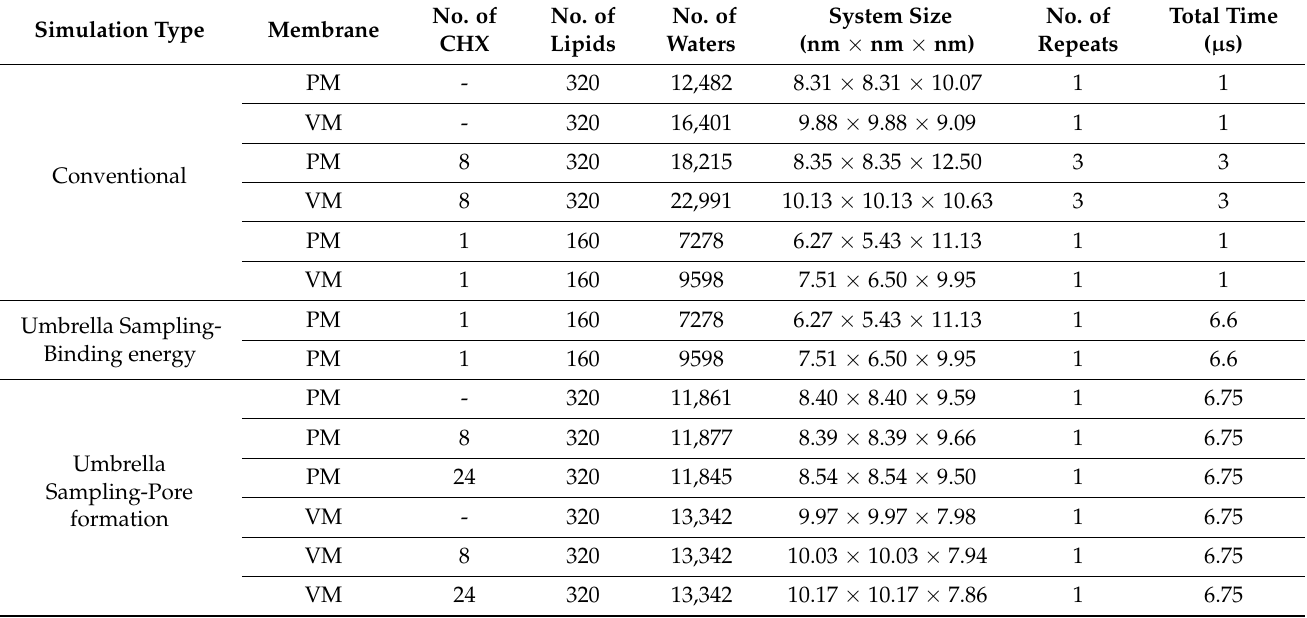
Table 3. All the simulations carried out to study CHX-PM/VM